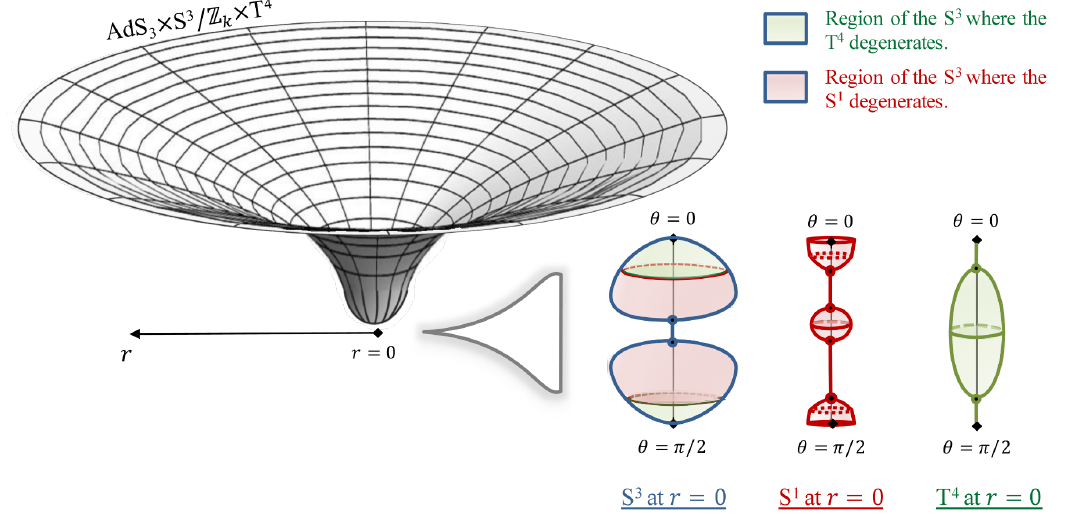
Figure 13 . Schematic description of the spacetime induced by a chain of 5 rods, inducing the degeneracy of either the S 1 ( y ) or a T 4 direction or the Hopf angle of the S 3 . On the left-hand side, we depict the overall geometry in terms of r . On the right-hand side, we describe the behavior of the S 3 , S 1 , and T 4 at r = 0 and as a function of θ . At r = 0 , the spacetime ends smoothly as a coordinate degeneracy of either the S 1 or the T 4 or the S 3